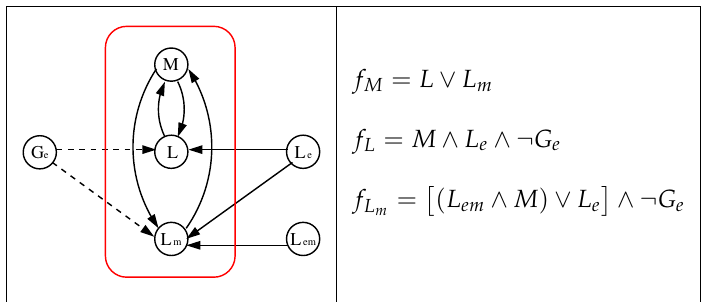
Figure 3. The reduced model of [20] ( left ) and its local Boolean functions ( right ). Dashed/solid edges represent